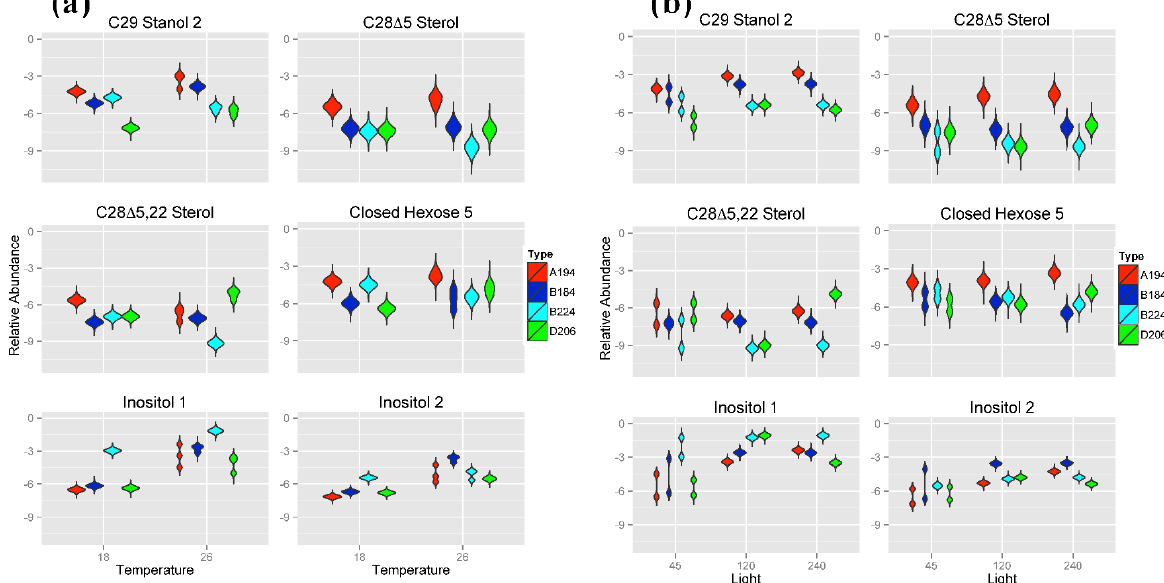
Figure 5. Violin plots showing posterior distributions of estimates of the top six significant predictor metabolites of Symbiodinium type. Metabolite abundance values are Area Under the Curve (AUC)-normalized. Predictor metabolites are sorted from top left to lower right according to their relative importance scores derived from Random Forests